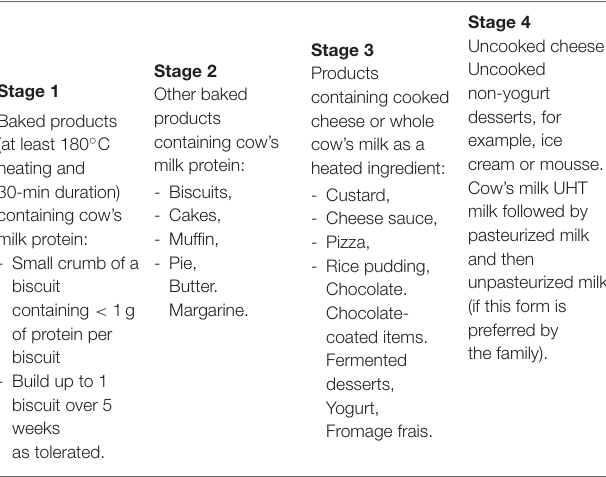
TABLE 3 | Milk ladder: classification of cow’s-milk-containing foods* (97,